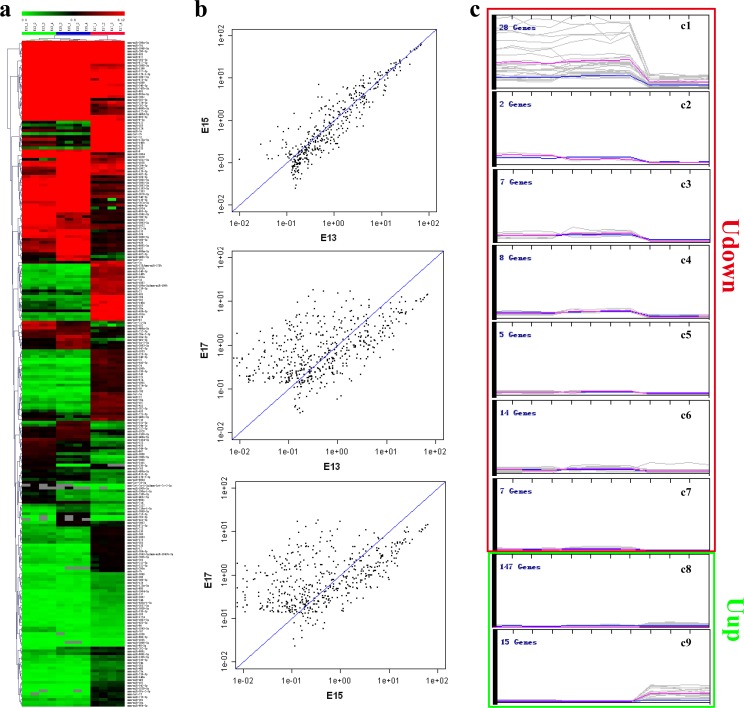
MicroRNA expression pattern analyses.(a). Heat-map and hierarchical clustering of differentially-expressed microRNAs in amniotic fluid on E13, E15, and E17, tested by one-way ANOVA, p<0.01.(b) Correlation scatter-plots of microRNA expression on E13, E15, and E17. (c) Expression patterns of microRNAs analyzed using self-organizing map algorithm. The Udown group is contained seven clusters (c1-c7) and the Uup microRNA group contained two clusters (c8 and c9).